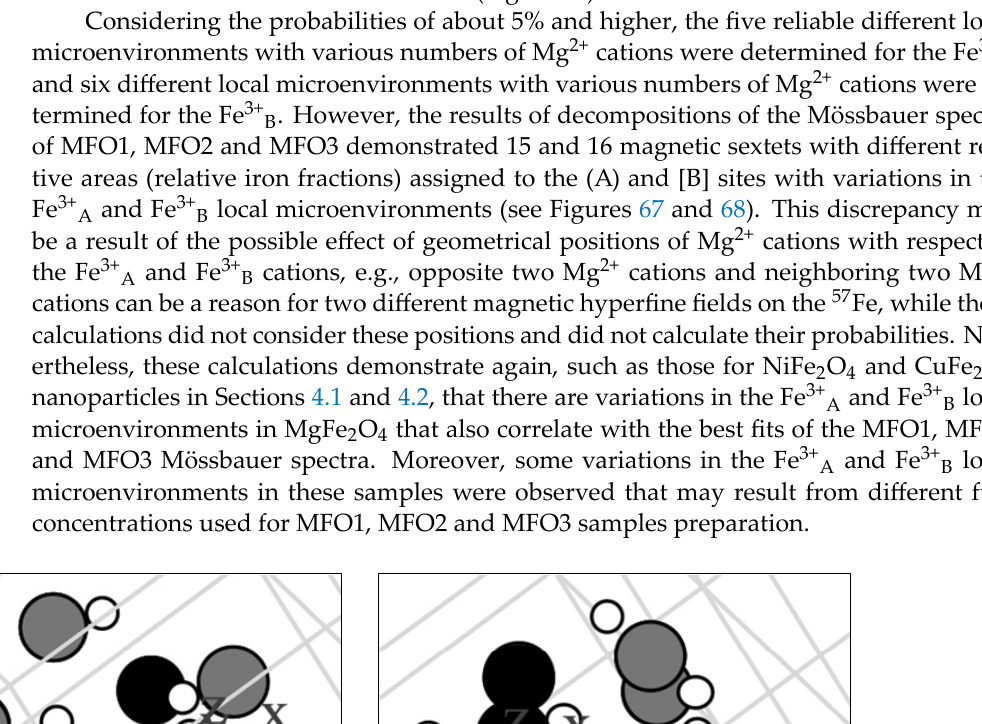
( b ) Figure 72. Histograms of the probabilities of different numbers of Mg 2+ cations in the Fe 3+A ( a ) and Fe 3+B ( b ) local microenvironments within the coordination sphere of 3.7 Å in the ideal MgFe 2 O 4 crystal with Fe and Mg compositions for MFO1, MFO2 and MFO3 samples. Adapted from Ref. [94] with permission from Elsevier: Journal of Alloys and Compounds, Vol. 912, Ushakov M.V., Nithya V.D., Rajeesh Kumar N., Arunkumar S., Chukin A.V., Kalai Selvan R., Oshtrakh M.I., “X ‐ ray dif ‐ fraction, magnetic measurements and Mössbauer spectroscopy of MgFe 2 O 4 nanoparticles”, 165125, ©2022. 5. FINEMET Alloys The nanostructured Fe ‐ Si ‐ B ‐ Nb ‐ Cu alloys prepared by annealing amorphous alloys made by the single roller method over their crystallization temperature demonstrated magnetic properties (e.g., variations in permeability) that are widely used in the industry for many applications such as saturable reactors, choke coils and transformers, etc. These alloys, called “FINEMET”, were developed in 1988 [98] and are interesting by now for investigation using Mössbauer spectroscopy as one of the most powerful techniques. Variations in the soft magnetic properties of FINEMET alloys can be achieved by induc ‐ ing a variation in transversal magnetic anisotropy by stress annealing under different